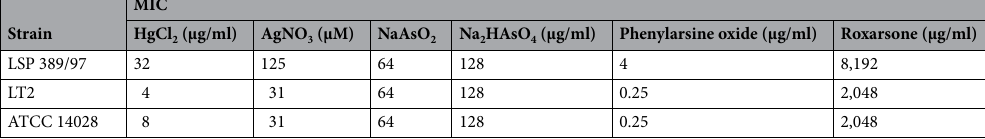
Table 1. Minimum inhibitory concentration (MIC) of heavy metals for Salmonella enterica serovar 4,5,12:i:- strain LSP 389/97 carrying plasmid pUO-STmRV1. S. enterica serovar Typhimurium strains LT2 and ATCC 14028 were included as negative